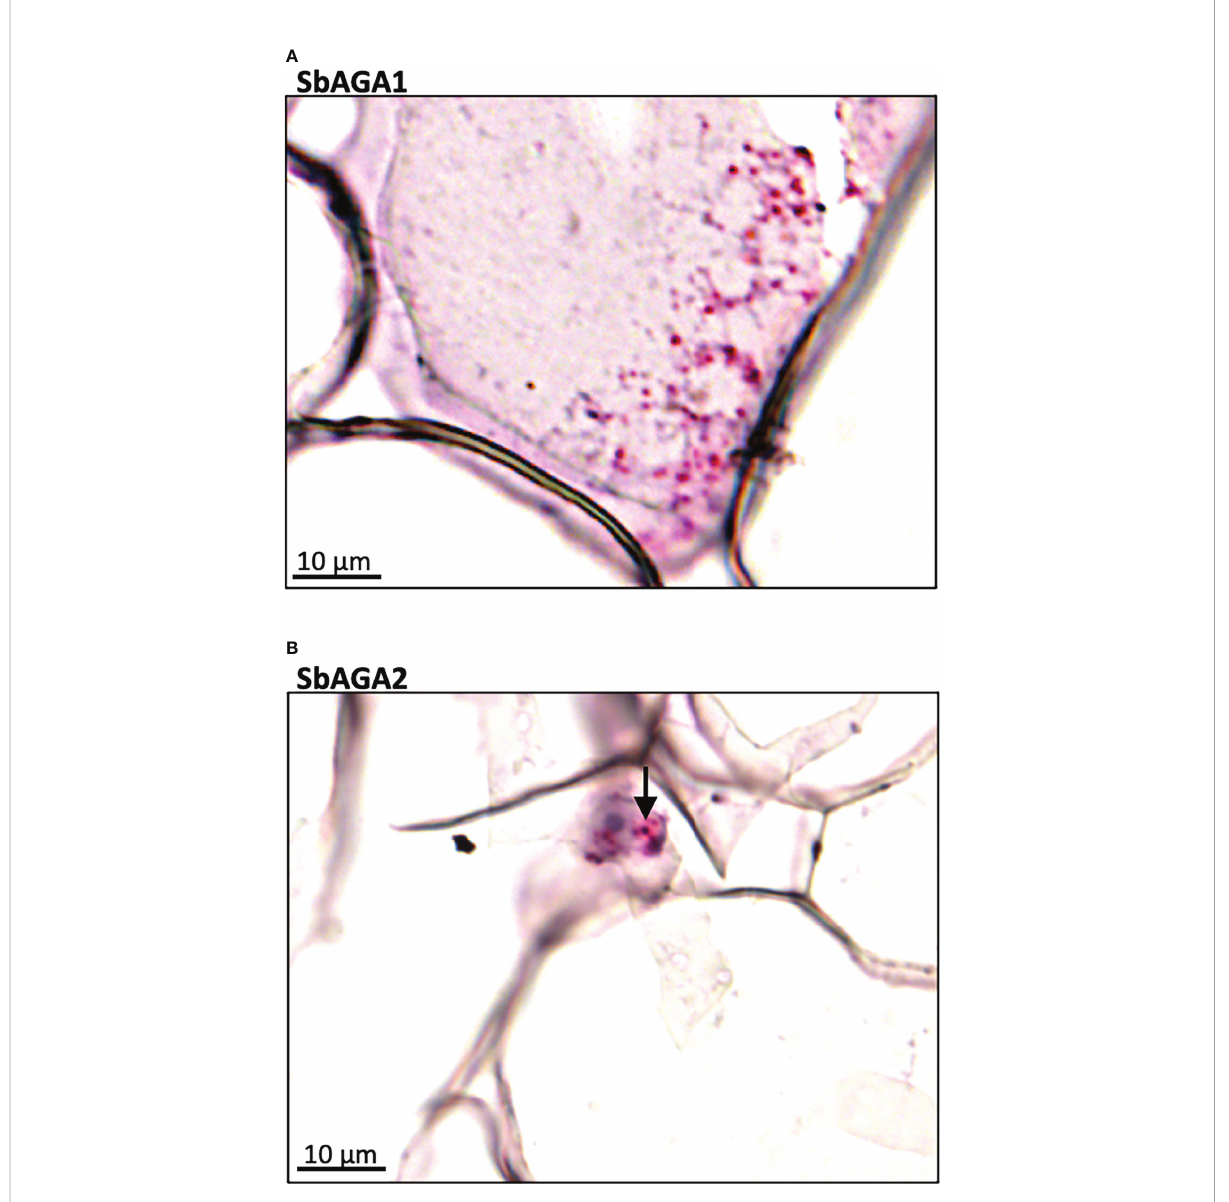
FIGURE 9 RNAscope data showing the localization of expression of SbAGA1 and SbAGA2 in pith parenchyma cells of the stem of the sweet sorghum Della after grain maturity (131 DAE). (A) shows the expression of SbAGA1 and (B) shows the expression of SbAGA2 . The red punctate structures indicate the locations of the transcripts. 40X